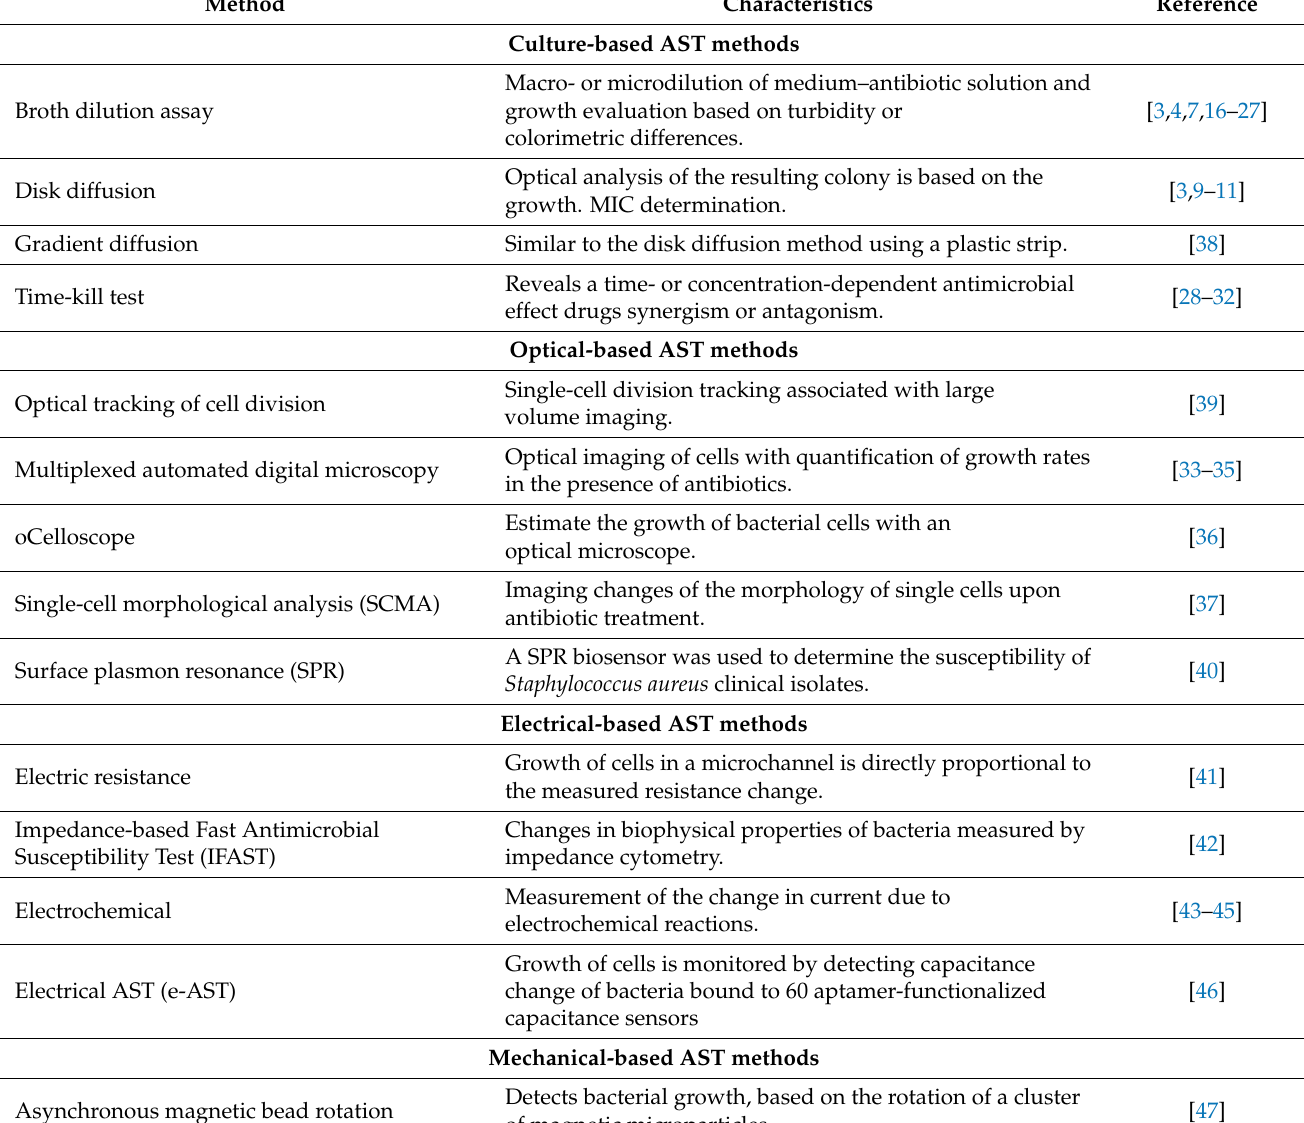
Table 1. Examples of current phenotypic antibiotic susceptibility testing (AST) methods that are classified according to the measuring principle: culture-based, optical-based, electrical-based and mechanical-based AST methods. MIC: minimal inhibitory concentration.